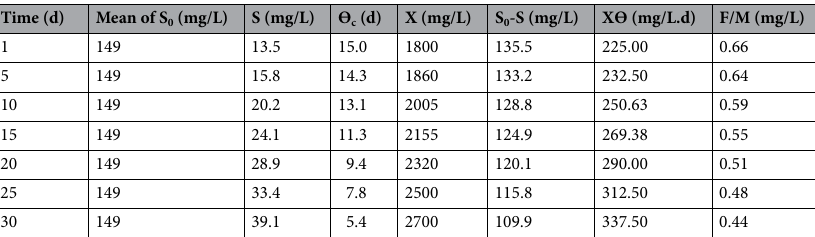
Table 4. Basic parameters of the operational and functional CMAS processes in ASM